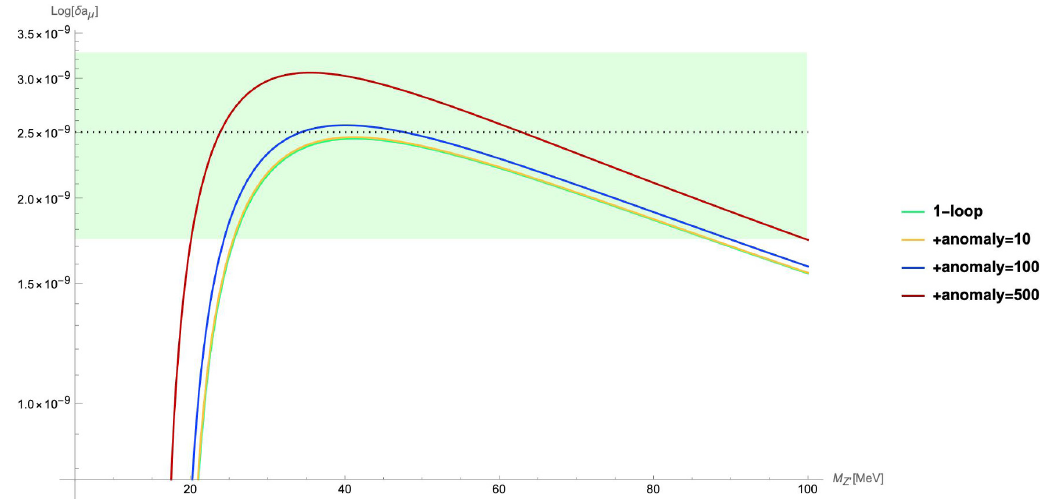
Figure 4 . In this plot, we add the one-loop and the anomalous contributions to the g − 2 of the muon for masses m use for the anomaly t